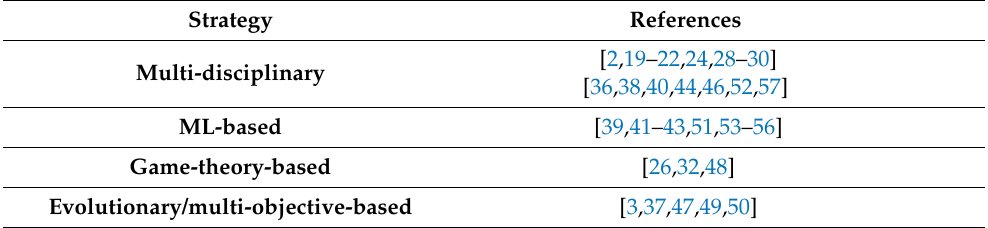
Table 1. Classification of different cloud data centre resource allocation strategies. Strategy